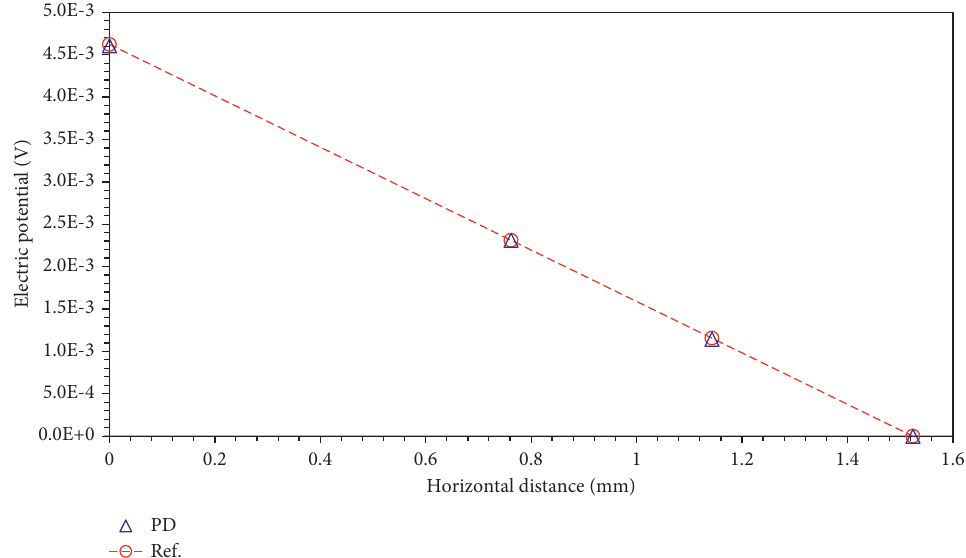
Figure 21: Comparison of potential values in case of temperature dependent material properties from PD and [90].